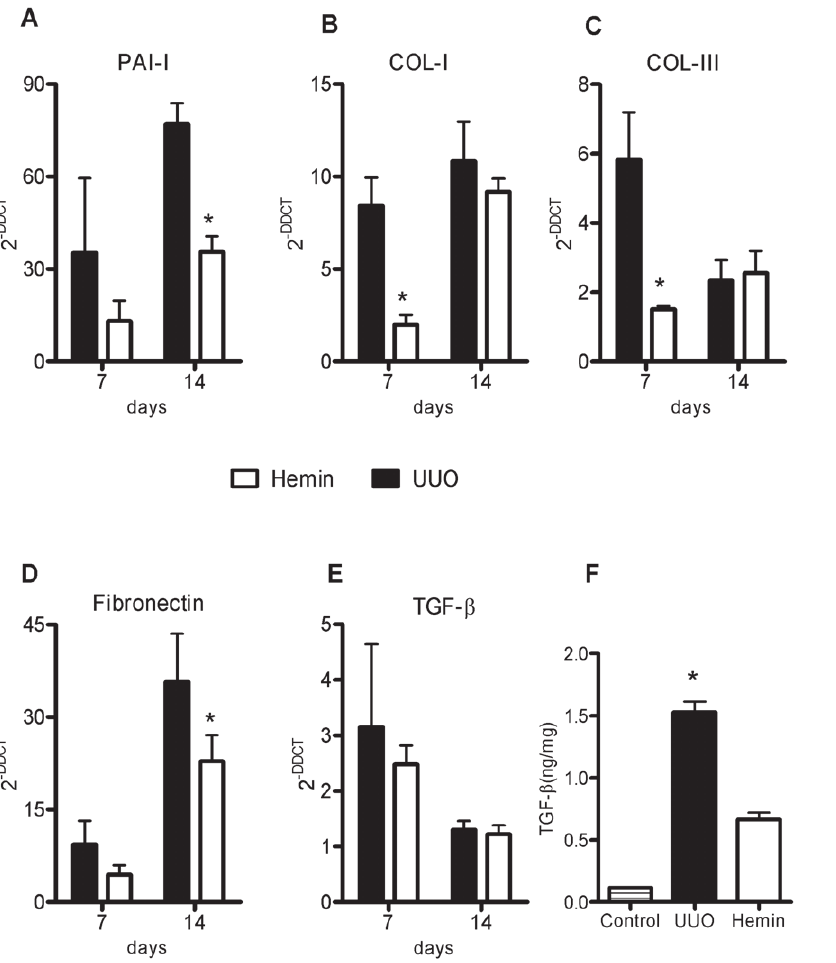
Figure 6. HO-1 upregulation leads to less fibrotic and extracellular matrix gene expression as well as TGF- b protein production. Relative mRNA expression (average 6 s.e.m.) of PAI-1 (panel A), collagen types I and III (panels B and C), fibronectin (panel D) and TGF- b (panel E). Samples were obtained from obstructed kidneys of UUO and Hemin-treated groups. Gene expression from control animals was assigned a value of 1. * p , 0,05 vs. UUO. (F) TGF- b protein, assessed by ELISA assay, in obstructed kidney samples from UUO and Hemin-treated animals. The amount of TGF- b quantified was divided by total tissue protein. * p , 0,05 vs. Control and Hemin.